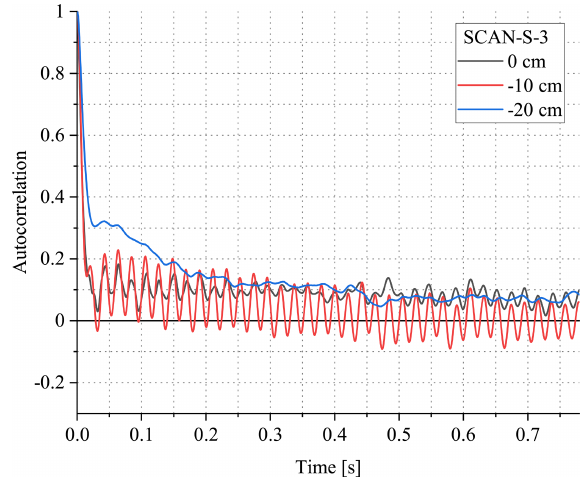
Figure 11. Autocorrelation functions of the time series n(t) recorded at various positions y during SCAN-S-3.